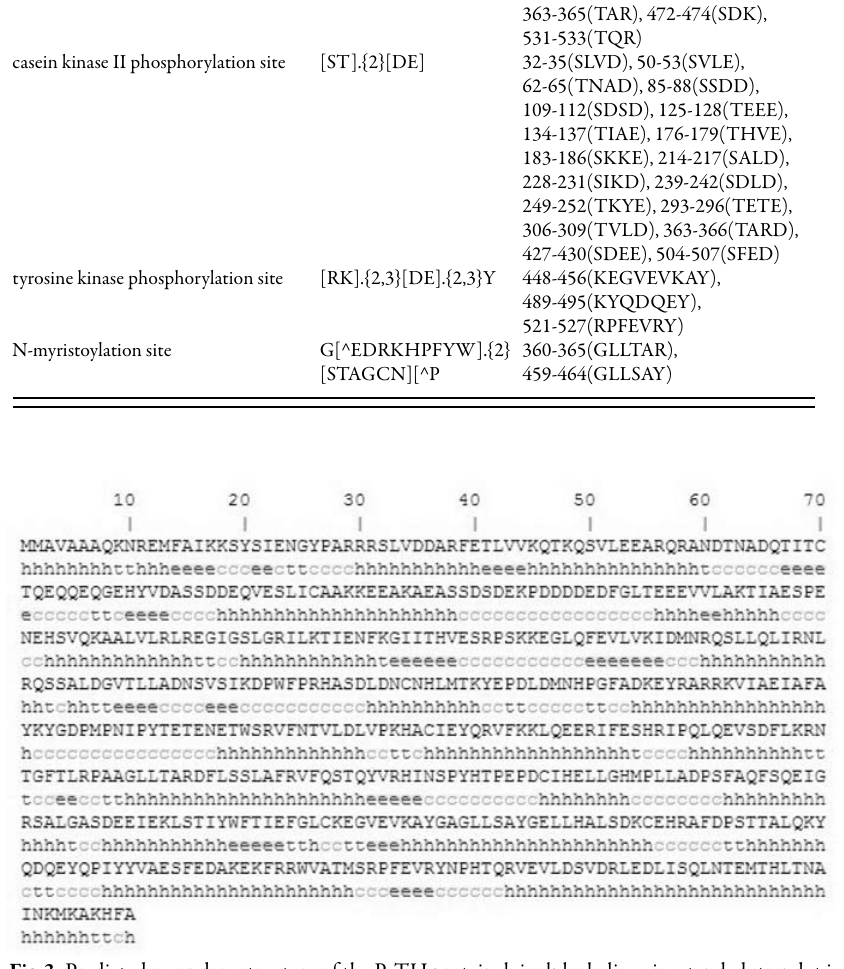
Fig.3. Predicted secondary structure of the PvtH protein, h is alpha helix; e is extended strand; t is beta turn; c is random